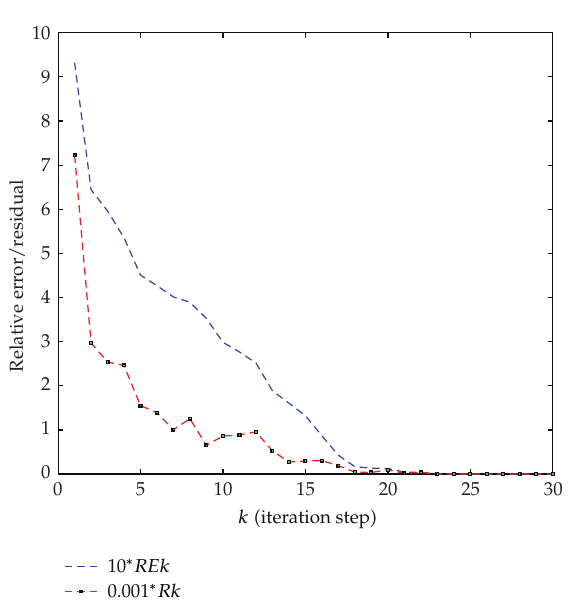
Figure 1: The relative error of the solutions and the residual for Example 4.1 with X 1 / (cid:4) 0 , Y 1 / (cid:4) 0.